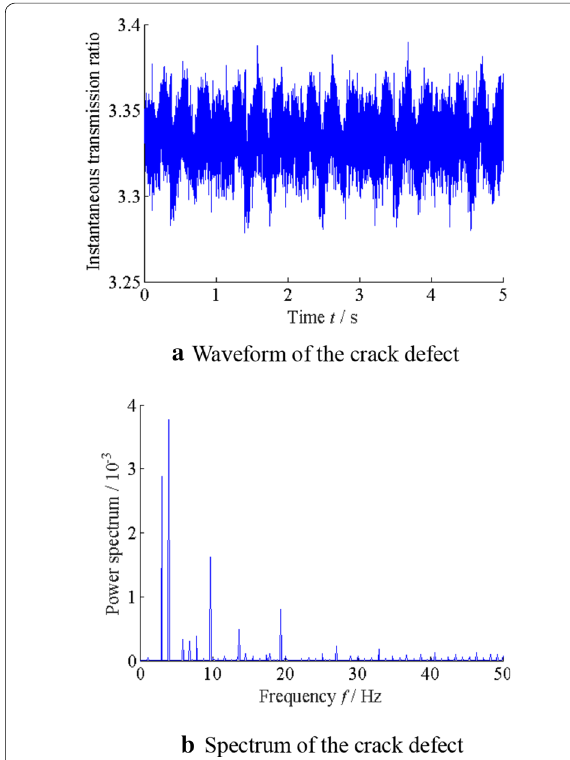
Figure 14 Signal of instantaneous transmission ratio for the crack defect